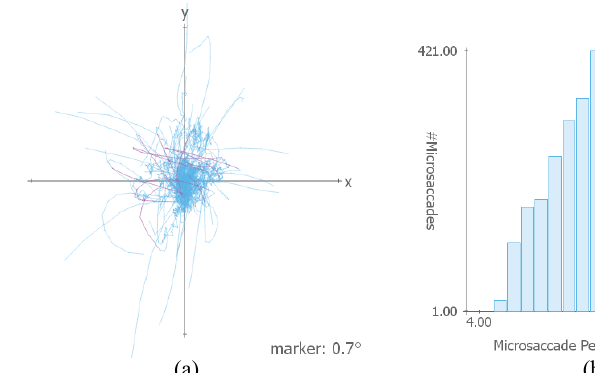
Figure 4. (a) Position of microsaccades relative to fixations of a trial in the context of the fixations that are plotted on top of each other (microsaccades are highlighted in pink). The marker value indicates the extent at the marked position on the x and y axis; values are measured in visual degree. (b) Histogram for microsaccade peak velocity and (c) the relationship between amplitude and peak velocity as scatterplot using a logarithmic scale for the painting data